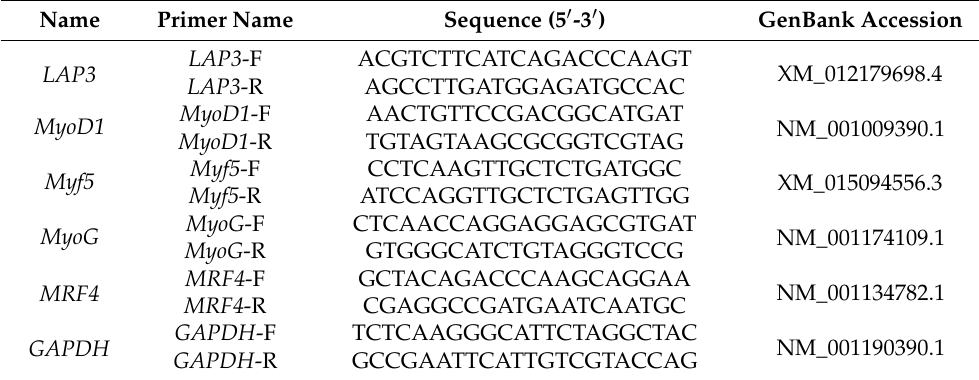
Table 3. Specific primers used for